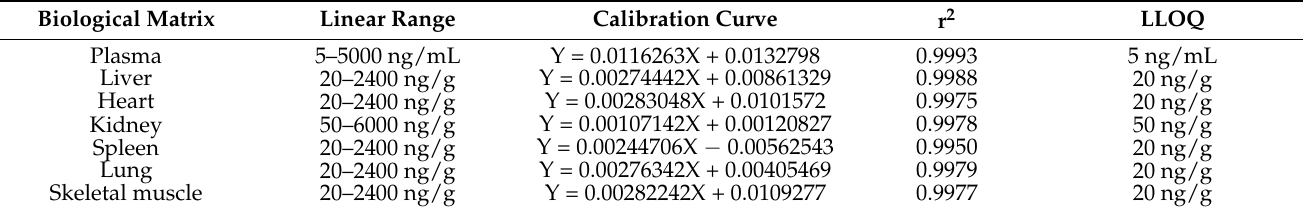
Table 1. The linear regression parameters for doxorubicin in rat plasma and six tissues. Biological Matrix Linear Range Calibration